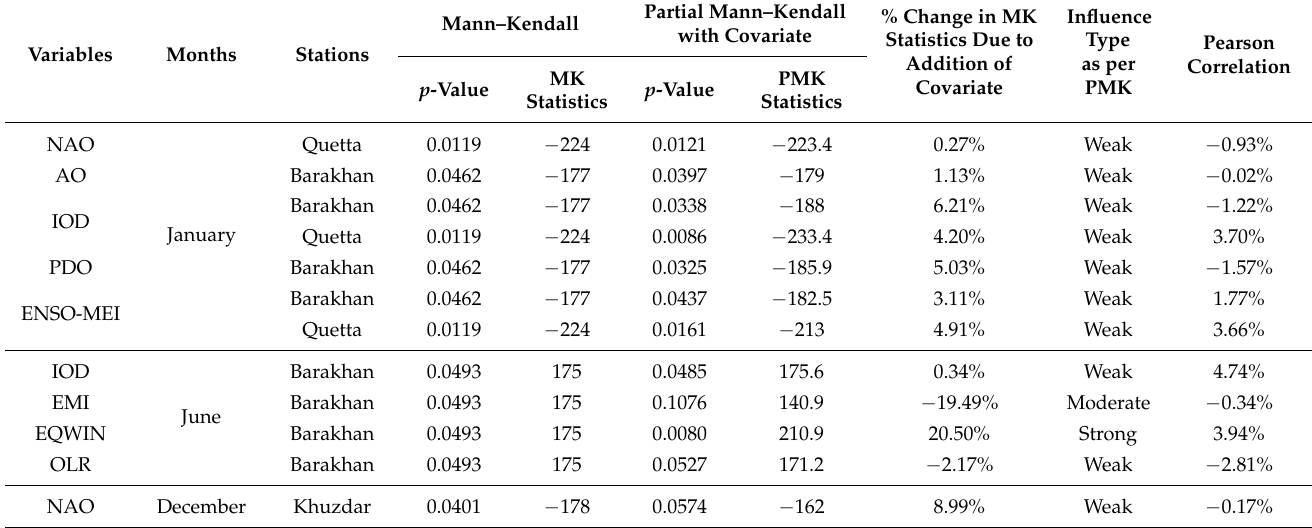
Table 7. Influence of climatic index on precipitation